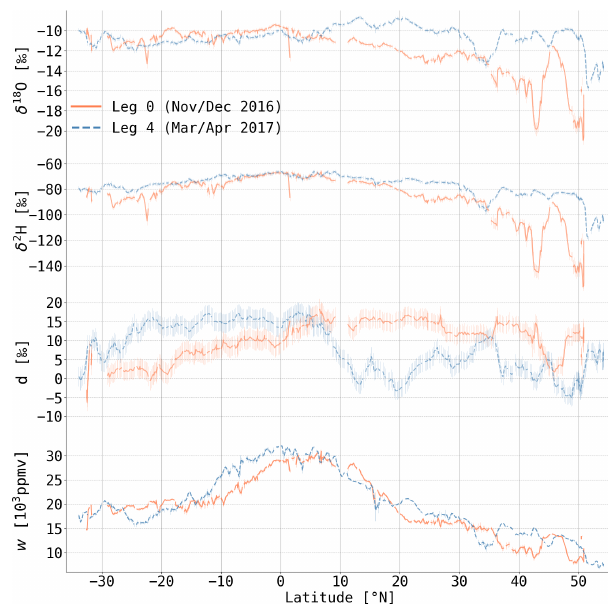
Figure 4. Hourly time series of δ 18 O, δ 2 H, d and w during legs 0 and 4 from SWI-13 versus latitude along the ship track. The error bars denote hourly standard deviations of the 1s